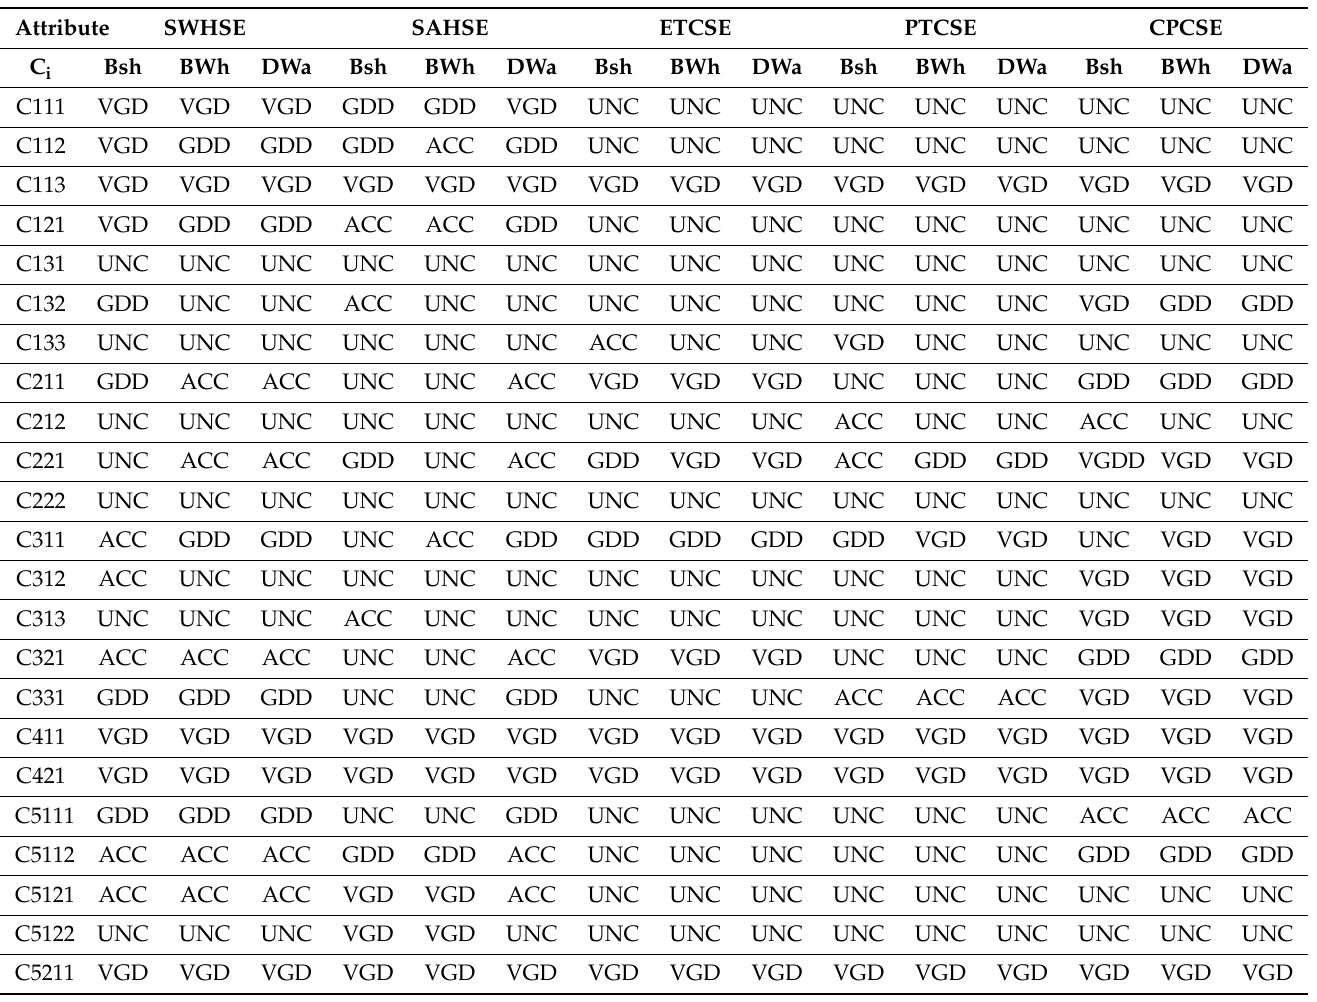
Table 8. Ranking of basic attributes for Niger (Bsh), Riyadh (BWh) and Beijing (DWA) climate zone for single effect